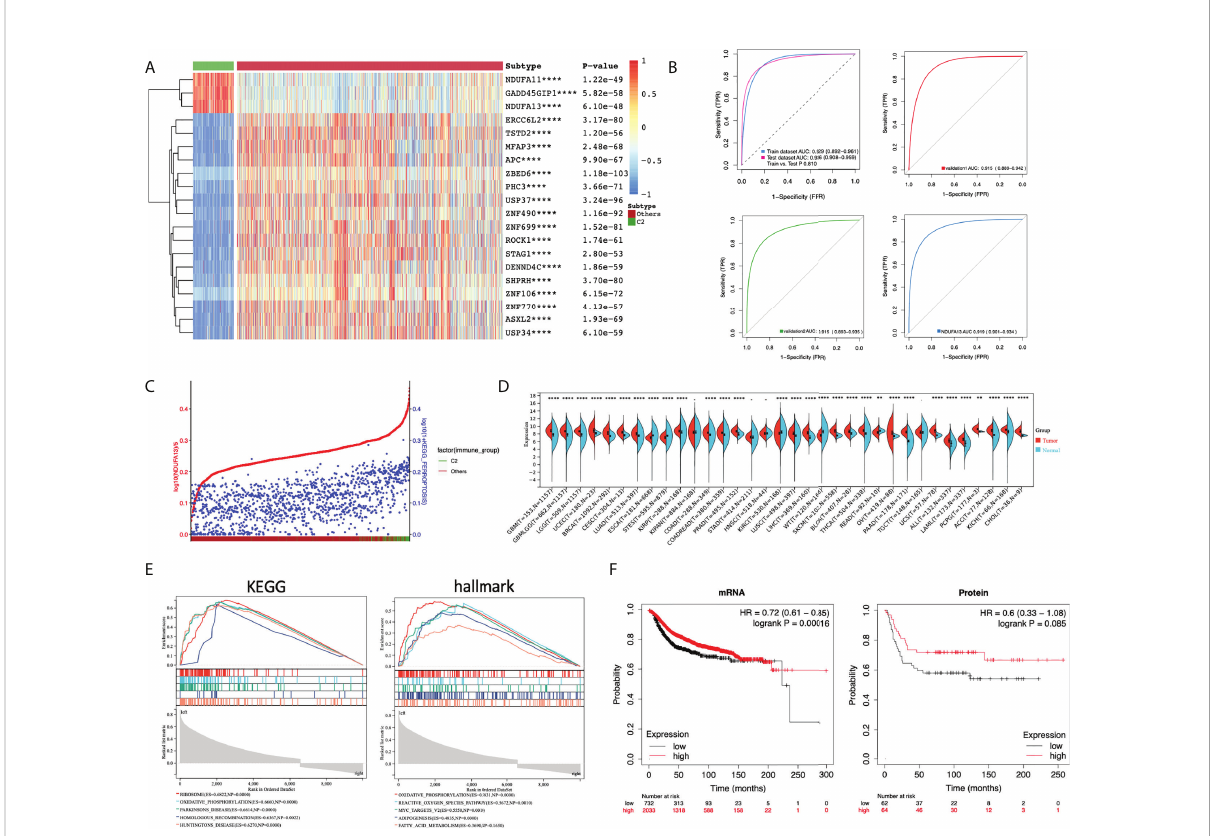
FIGURE 5 Selection of putative biomarker for cluster 2 patients. (A) Heatmap of the top 20 putative biomarkers between cluster 2 and other breast cancer patients. DEGs were calculated using limma; DEGs with adjusted P -value < 0.05 and |log2FC| > 1 were selected for ROC analysis. DEGs were ranged according to the AUC and only top 20 genes were illustrated. (B) ROC plot comparing the predictive value of the three over-expressed genes as biomarkers of cluster 2 patients. A three-gene index was generated using Lasso regression. The predicted value of the three-gene index generated was estimated with TCGA-BRCA patients divided equally into the training cohort and test cohort. Further validations were done using data from the METABRIC (validation 1) and MSK-IMPACT projects (validation 2). (C) Scatter plot showing the expression of NDUFA13 (red) and the PDS of ferroptosis pathway (blue) with patients annotated to cluster 2 or others. Patients were ranged by the expression of NDUFA13. (D) Pan-cancer expression analysis of NDUFA13 in 27 cancer types using TCGA PANCAN and GTEx dataset. (E) GSEA plots of NDUFA13-related pathways and cancer hallmarks. (F) Kaplan – Meier survival plots for NDUFA13 expression in breast cancer. Distant metastasis-free survival (DMFS) was used as an endpoint. A two-sided P -value < 0.05 was considered signi fi cant. **P < 0.01; ****P <